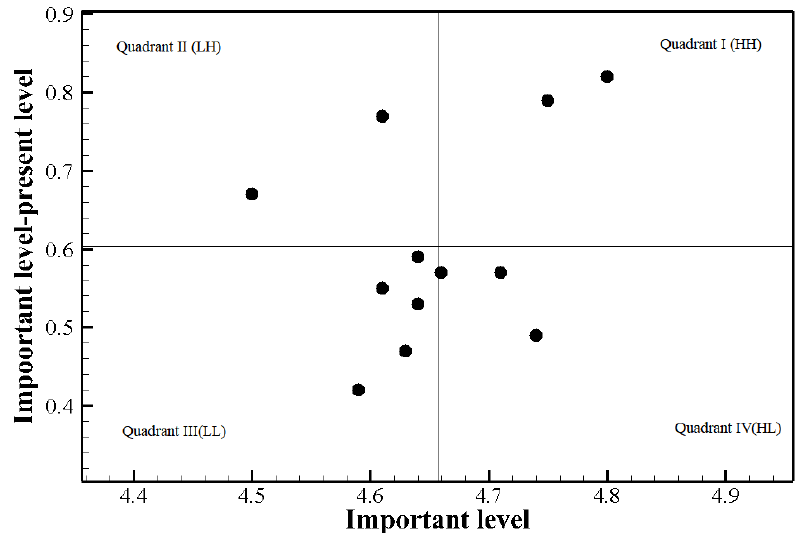
Figure 3. The Locus for Focus model analysis of participants with prior COVID-19 patient care experience.